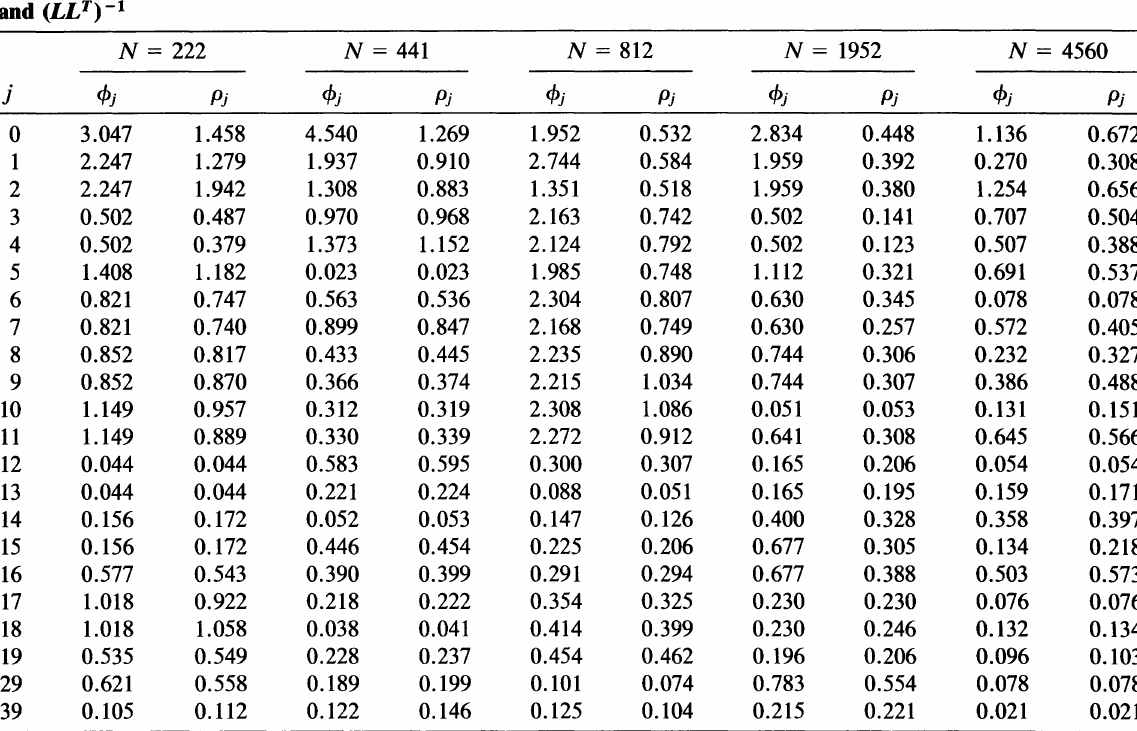
Table 1. Experimental Convergence Rates and Comparison between Pj and c/Jj for Preconditioners A-I and (LLT)-1